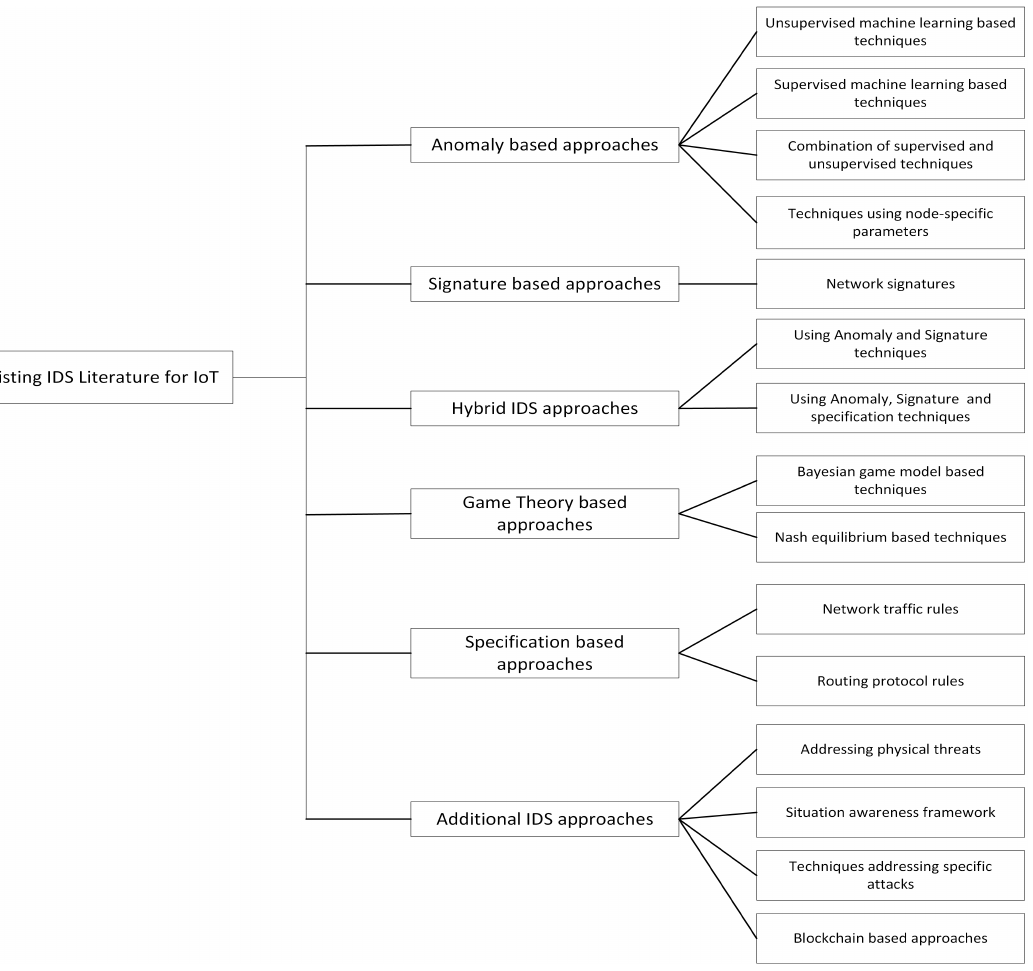
Figure 2. Categorization of IDS for IoT